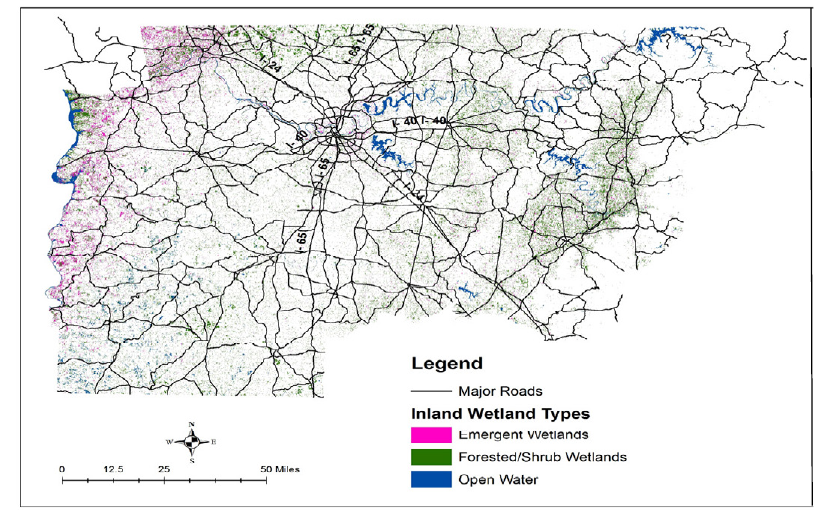
Fig. 4: Classification of inland wetlands derived from Landsat 8 satellite data